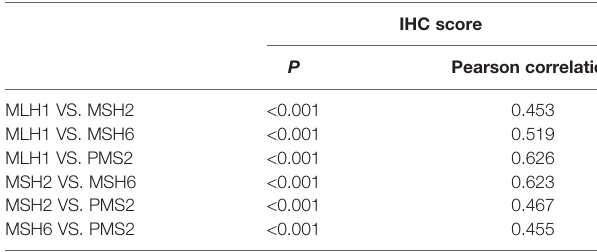
TABLE 2 | Correlation analysis of the four MMR protein